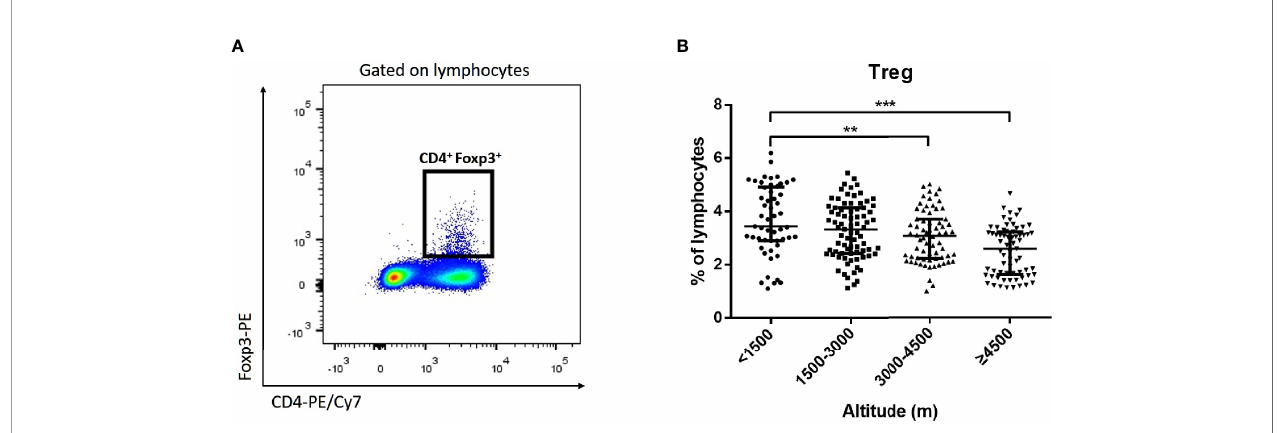
FIGURE 5 | Proportion of Tregs among HAdV infectious patients at different altitudes. Comparison of Tregs among HAdV infectious patients at different altitudes. (A) Representative FACS plots of the Tregs distinguished by CD4 and Foxp3. (B) Comparison of Tregs among HAdV infectious patients at different altitudes. The Kruskal – Wallis test (followed by post-hoc analysis with Dunnett ’ s t -test with Bonferroni adjustment) is applied to compare the differences between the low-altitude group (<1,500 m) and the other groups. ** P < 0.01, *** P <